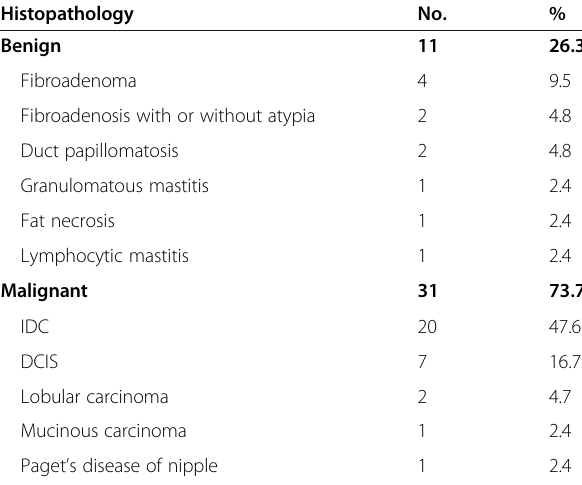
Table 4 Distribution of the biopsied cases according to histopathology results ( N = 42)